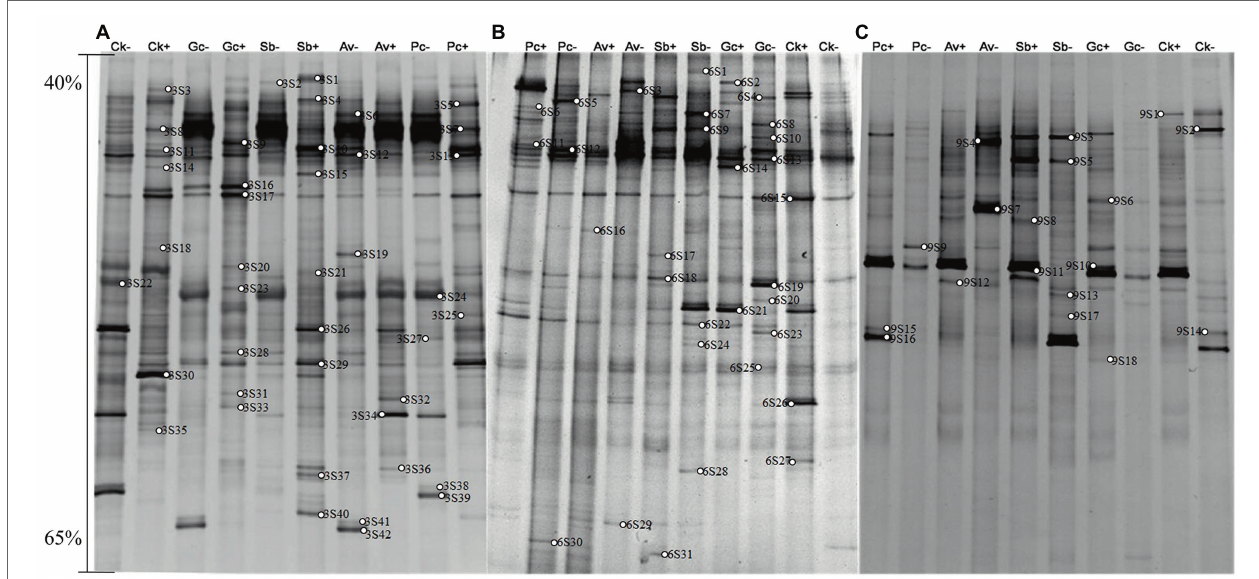
FIGURE 3 | DGGE pattern of nested PCR-amplified rRNA gene fragments of fungi from P. tabulaeformis rhizosphere soils ( A-C represent rhizosphere soils were sampled at 3, 6, and 9 months after PWN inoculation) of different ECMF and DSE inoculation treatments after PWN inoculation. Lanes labeled Gc, Sb, Av, and Pc in A-C represent P. tabulaeformis seedlings were inoculated with G. cylindrosporus , Suillus bovinus , A. vaginata , and P. chrysanthemicola , respectively; Ck as control group. “+” and “ − ” represent P. tabulaeformis seedlings were inoculated with PWN and were not inoculated with PWN, respectively. The linear gradient used was from 40 to 65% denaturant. The bands labeled 3S1-3S42 in A , 6S1-6S31 in B , and 9S1-9S18 in C were selected and excised from the DGGE gels and used for cloning and sequencing.